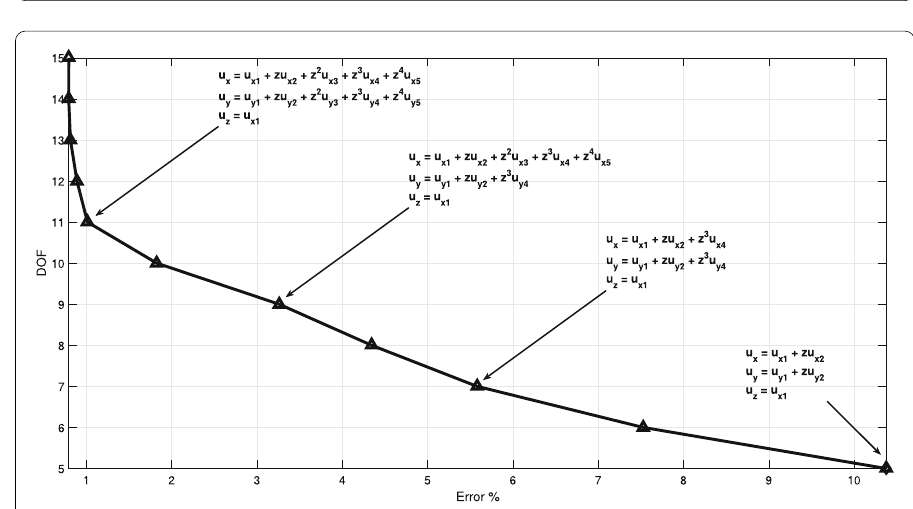
Fig. 16 BTD for 0/90/0/90, a/h = 10 with eleven, nine, seven and five DOF models